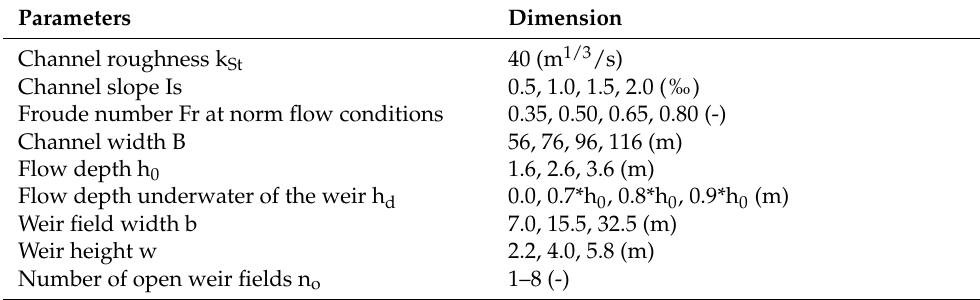
Table 1. Examined parameters and the selected dimensions.